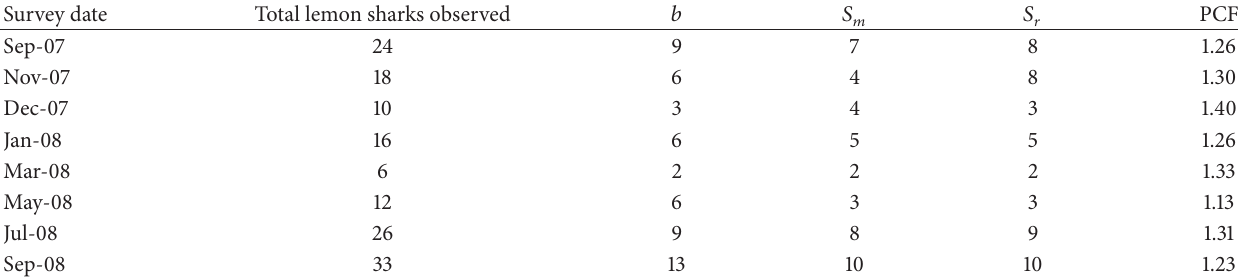
Table 1: Perception correction factor (PCF) values for each aerial survey, where “ 𝑆 𝑚 ” is the number of sharks seen by observer 1 only, “ 𝑆 𝑟 ” is the number of sharks seen by observer 2 only, and “ 𝑏 ” is the number of sharks seen by both observers.